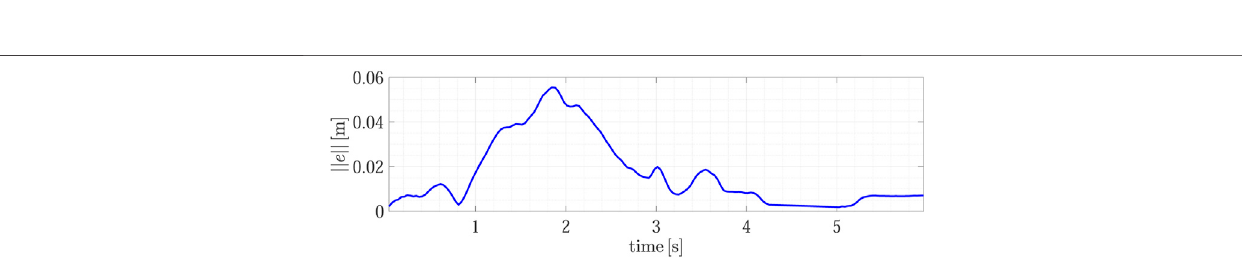
FIGURE 6 | First experiment (Object A): visual servoing tracking error during the H2R operation.